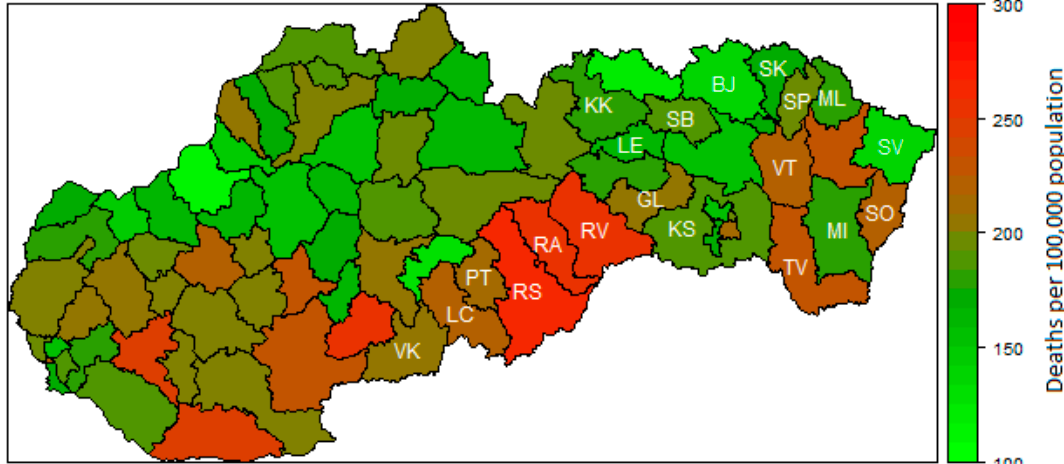
Figure 2. Preventable mortality of women in 2015. Note: Luˇcenec district (LC), Polt á r district (PT), Rev ú ca district (RA), Rimavsk á Sobota district (RS), Vel’k ý Krt í š district (VK), Kežmarok district (KK), Sabinov dsitrict (SB), Svidn í k district (SK), Vranov nad Topl’ou district (VT), Gelnica district (GL), Rožˇnava district (RV), Sobrance district (SO), Trebišov district (TV), Bardejov district (BJ), Medzilaborce district (ML), Košice–okolie district (KS), Levoˇca district (LE), Snina district (SV), Stropkov district (SP), and Michalovce district